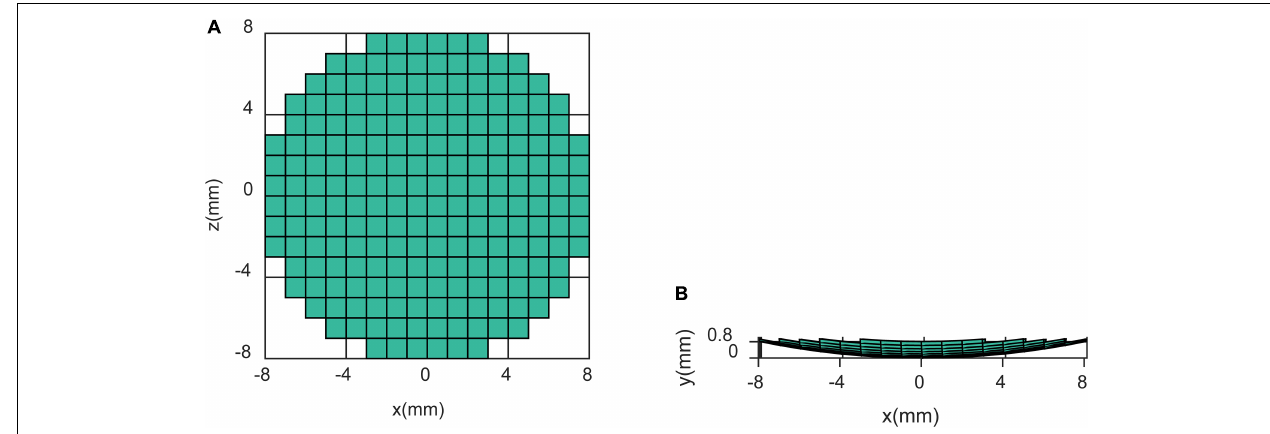
FIGURE 3 | Specification of the transducer at (A) the x – z section and (B) the x – y section.